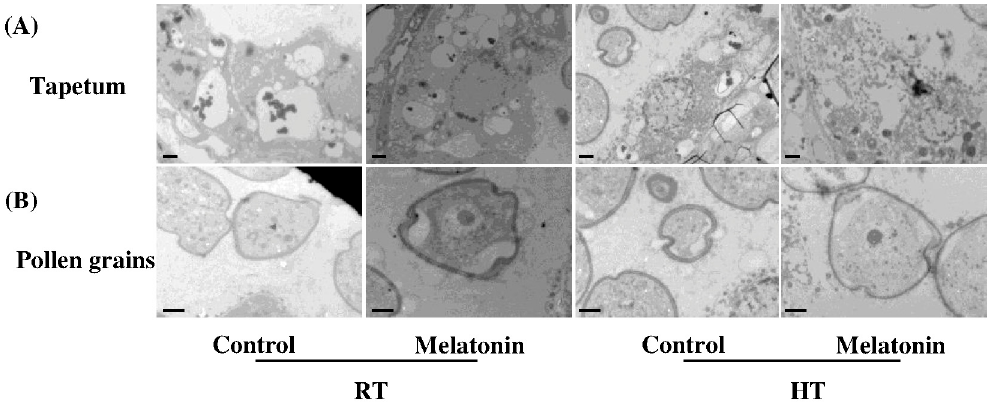
Figure 5. Ultrastructures of: tapetum cells ( A ); and pollen grains ( B ) at the early uninuclear microspore stage in tomato. Pollen is indicated with black arrows. Bars = 2 µm.